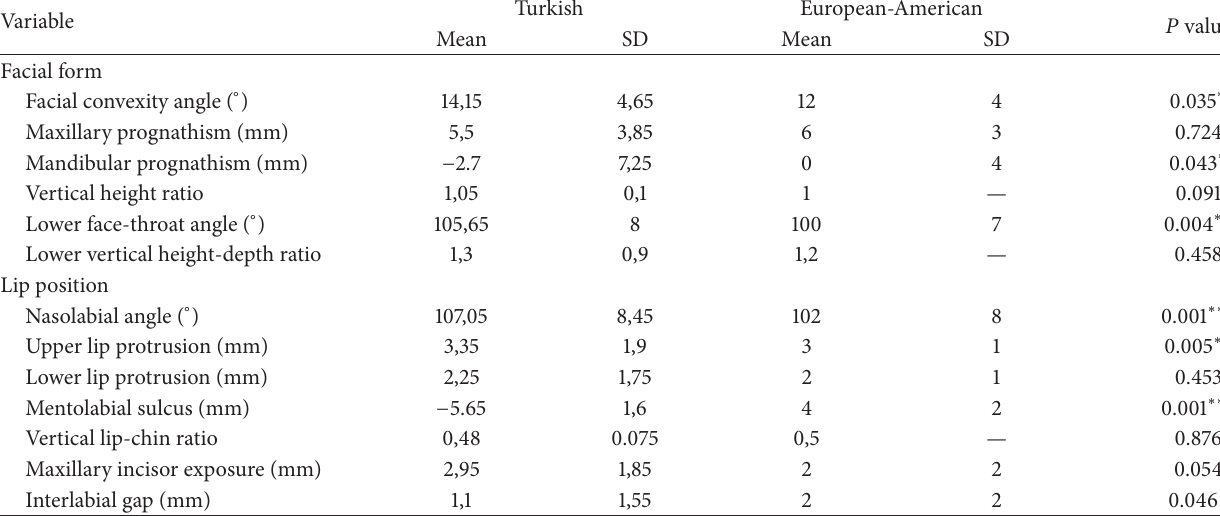
Table 1: Comparison of soft tissue cephalometric values of Turkish and European-American using Legan and Burstone analysis. Variable Facial